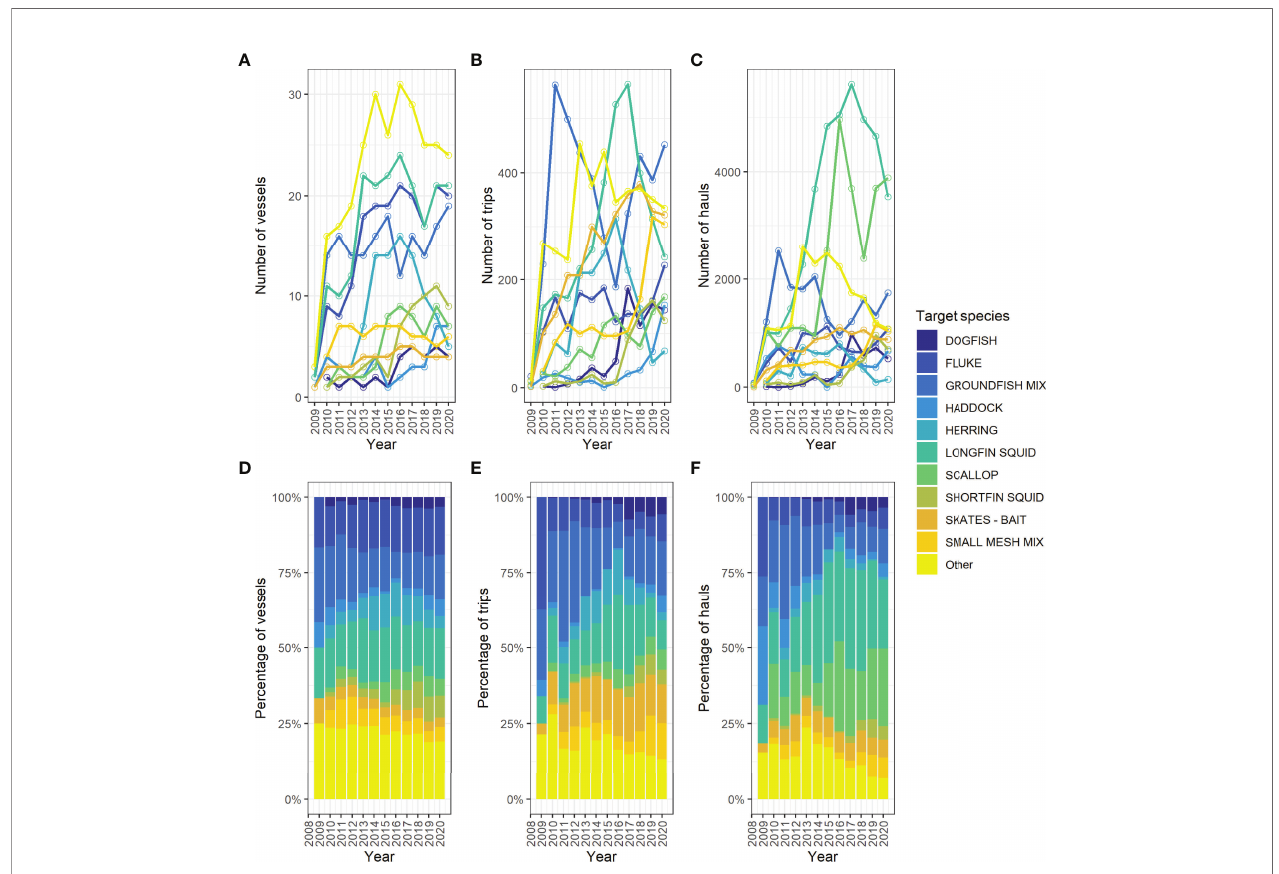
FIGURE 3 | The breakdown of Study Fleet number of vessels, trips, and hauls by target species through time. The trends through time for each level of the data are shown in panels (A – C) . The annual proportions of vessels, trips, and hauls are shown in panels (D – F) . The category ‘ Other ’ includes twenty additional target species designations each of which comprised less than three percent of the total trips records.